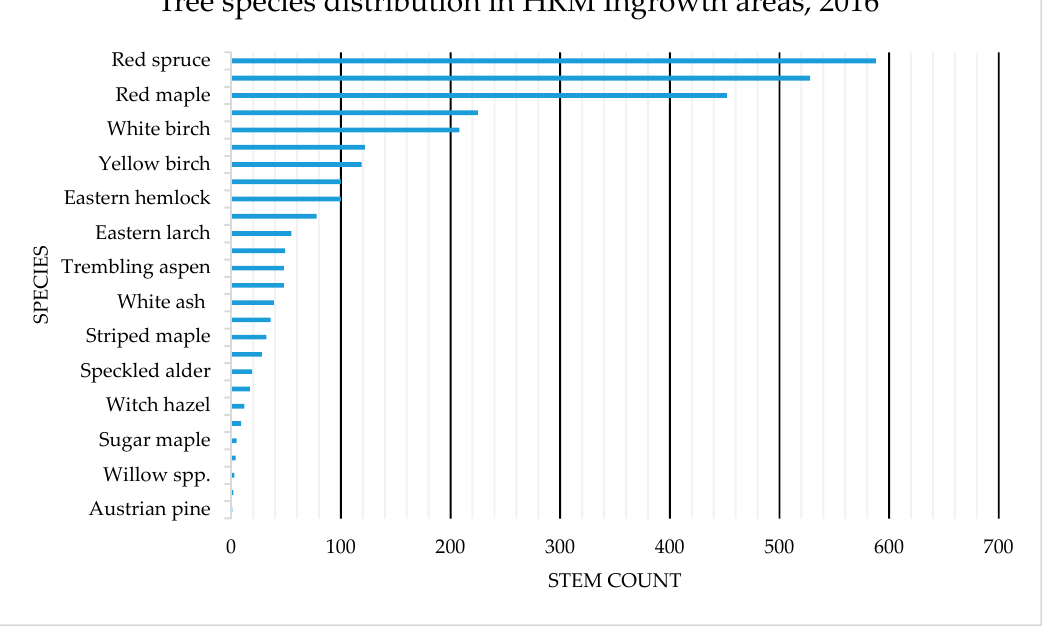
Figure A2. Total tree species distribution on OAGC, 2017 (lesser frequency) based on plot projections made using the area of forested patches.